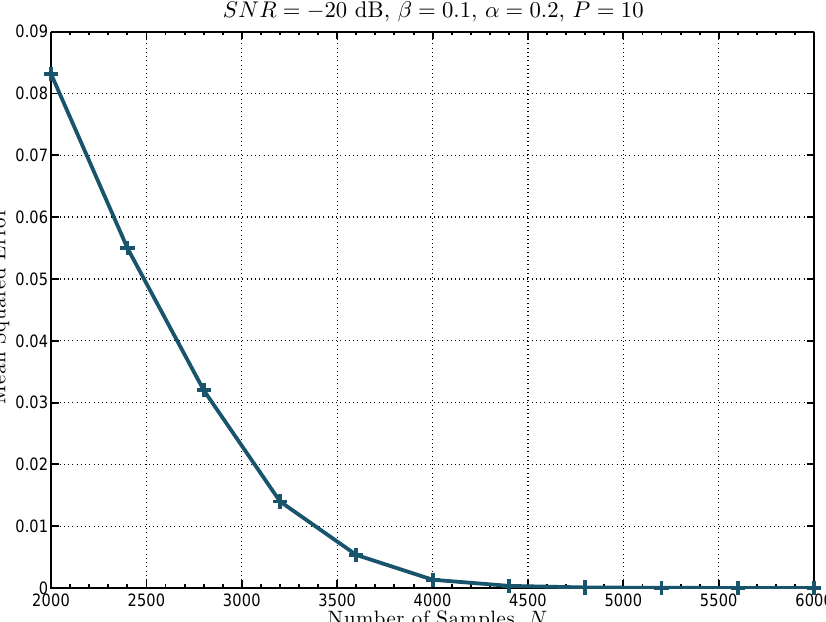
Figure 4. Mean squared error of the power function of the ST-based detector (ST-Det) test statistic against the number of samples N